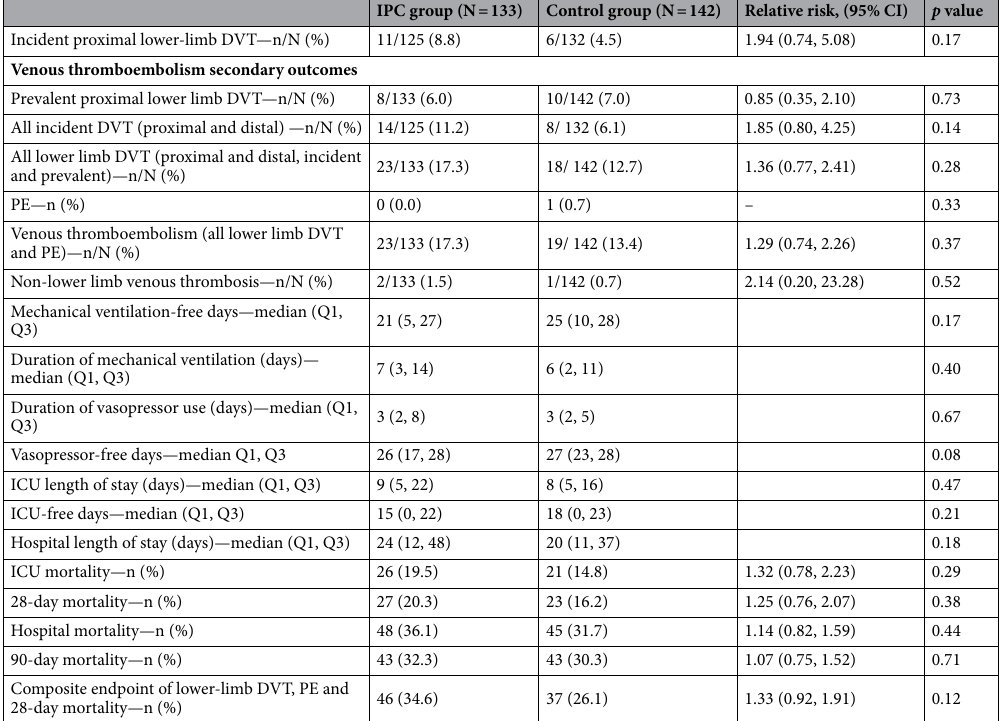
Table 3. Outcomes of patients with heart failure who were randomized to intermittent pneumatic compression with pharmacologic thromboprophylaxis (IPC group) or pharmacologic thromboprophylaxis alone (control group). CI Confidence interval, DVT Deep vein thrombosis, ICU Intensive care unit, IPC Intermittent pneumatic compression, Q1 First quartile, Q3 Third quartile, PE Pulmonary embolism.